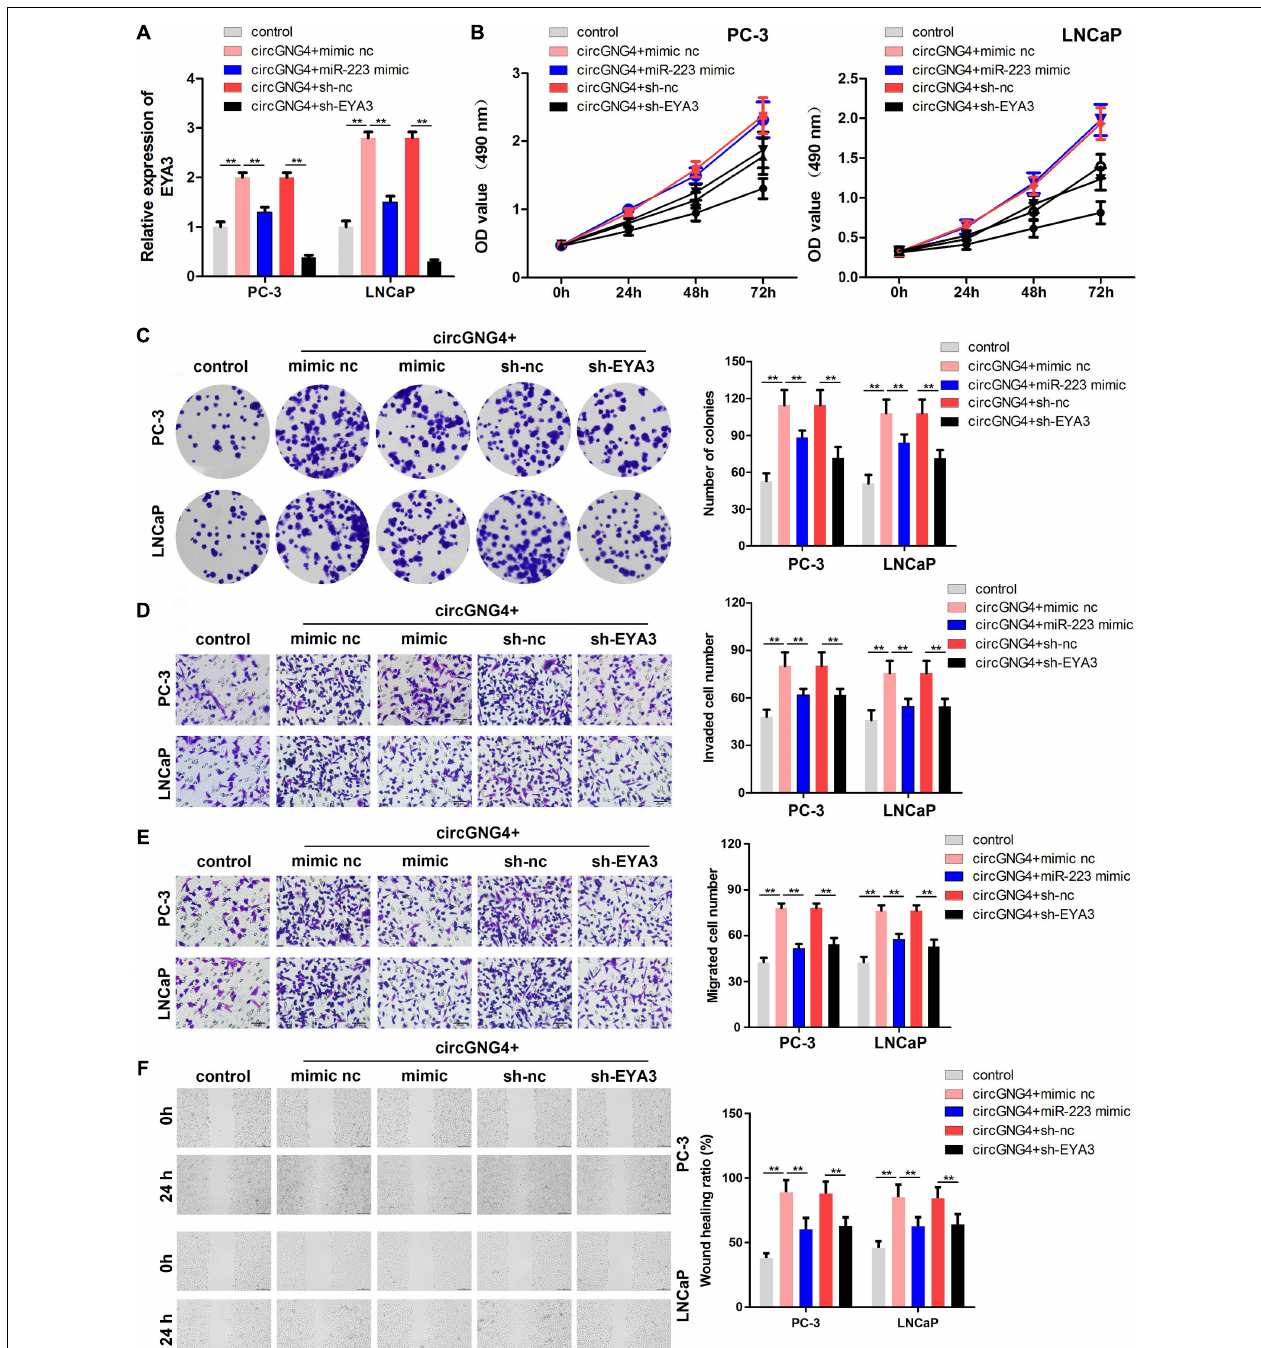
FIGURE 5 | Overexpression of miR-223 and knockdown of EYA3 reversed the oncogenic effect of circGNG4. (A) EYA3 expression levels were detected by quantitative PCR analysis (B) Detection of cell proliferation after circGNG4 knockout was determined using a Cell Counting Kit-8 assay. (C) . Experimental detection of cell clone formation after circGNG4 knockout. (D,E) . Cell migration and invasion were investigated using Transwell assays. (F) Cell migration was investigated using a wound healing assay. ** p < 0.01. circRNA/circ, circular RNA; GNG4, G protein subunit γ 4; miR,